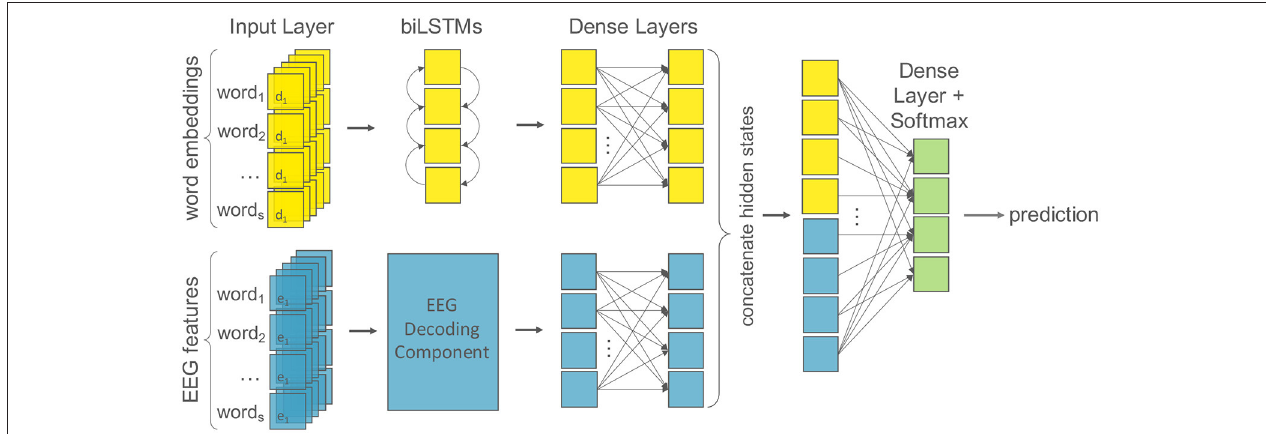
FIGURE 2 | The multi-modal machine learning architecture for the EEG-augmented models. Word embeddings of dimension d are the input for the textual component (yellow); EEG features of dimension e for the cognitive component (blue). The text component consists of recurrent layers followed by two dense layers with dropout. We test multiple architectures for the EEG component (see Figure 3 ). Finally, the hidden states of both components are concatenated and followed by a final dense layer with softmax activation for classification